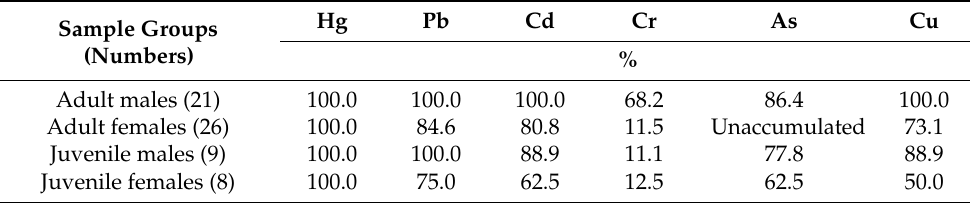
Table 5. The cumulative rate of toxic trace elements in human hair in the polluted area.